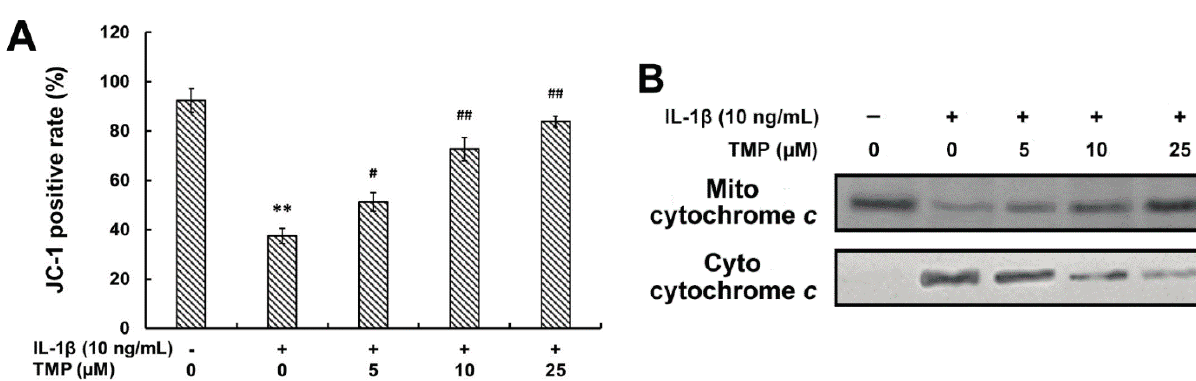
Figure 6. Effects of TMP on IL-1 β -induced mitochondrial dysfunction in TR-iBRB2 cells. After treatment of indicated drugs, the level of MMP was determined using the ratio of fluorescence at 590 nM to that at 530 nM ( A ) and the expression of cyto- and mito-cytochrome c was determined by Western blot analysis ( B ). All data were expressed as mean ± SD of three experiments. ** p < 0.01 vs. control group; # p < 0.05; ## p < 0.01 vs. IL-1 β -treated group.